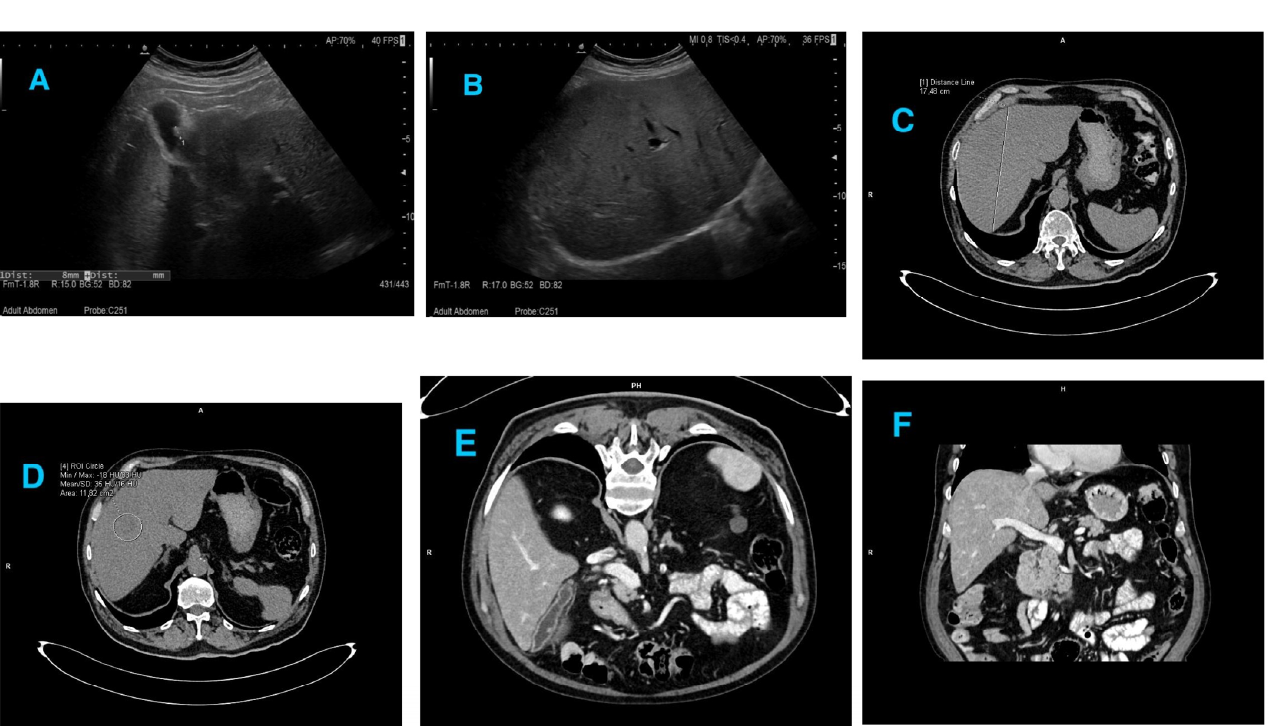
Figure A1. Pictures ( A – F ) Diagnostic imaging. ( A ) A polyp in the gallbladder shown in the ultrasound examination of the abdomen. ( B ) Hepatic steatosis of the liver shown in the ultrasound examination of the abdomen. ( C ) Enlarged liver shown in the abdominal CT scan with contrast. ( D ) Hepatic steatosis shown in the abdominal CT scan with contrast. ( E ) A polyp in the gallbladder shown in the abdominal CT scan with contrast. ( F ) Homogeneous intraluminal signal of the lumen of the portal vein shown in the abdominal CT scan with contrast.